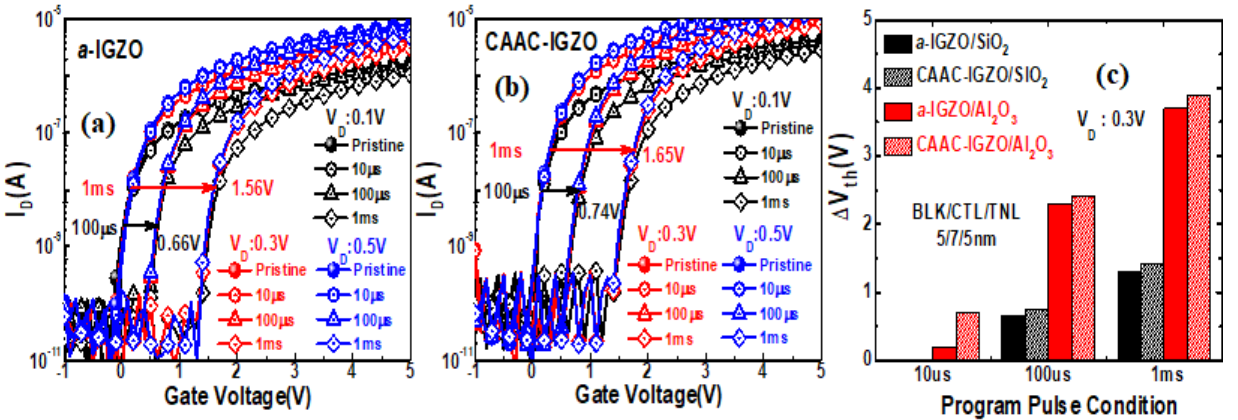
Figure 6. Memory performance of devices using amorphous and crystallized IGZO active layers with different pulse conditions: ( a ) a-IGZO and ( b ) CAAC-IGZO. ( c ) V th shift for different TNLs and program pulses.